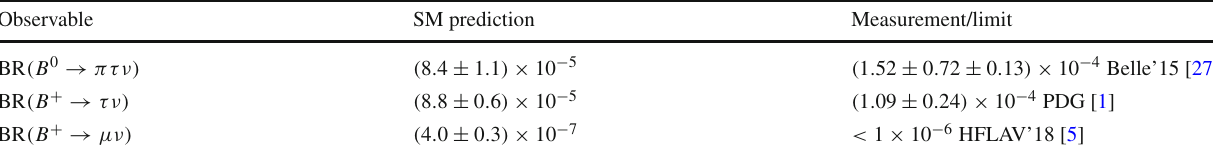
Table 10 Datasets on further charged current B -meson decays. The SM predictions are obtained using flavio [199] Observable